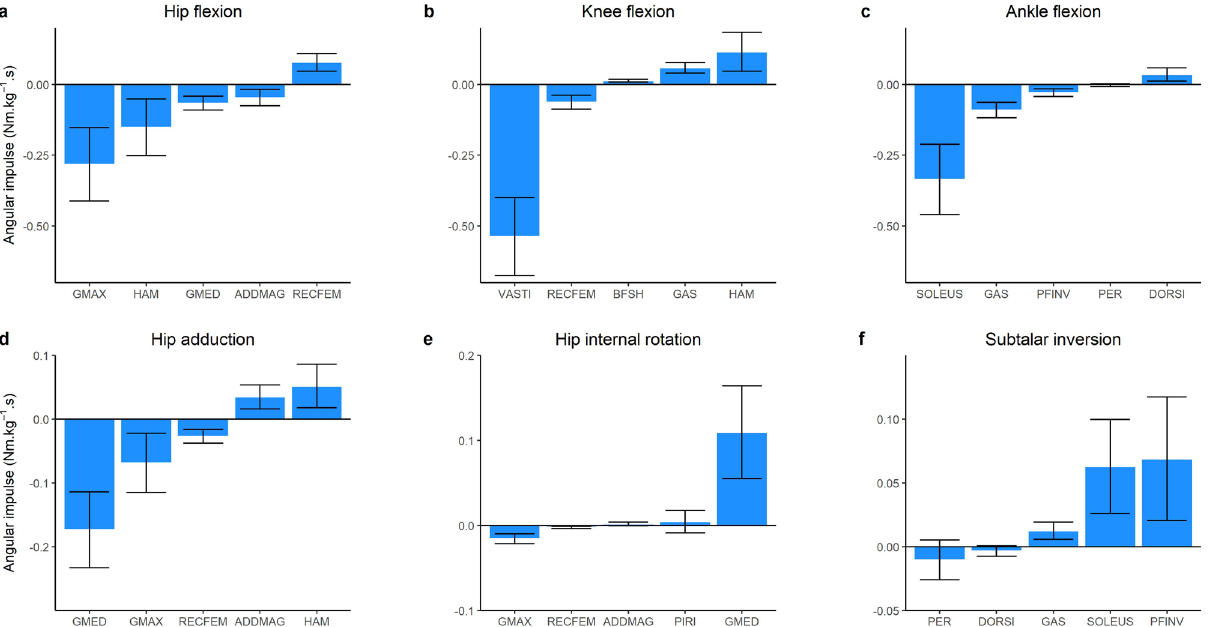
Figure 6. Mean (bars) and SD (error bars) musculotendinous contributions to the body mass normalised joint angular impulse across the landing phase (initial contact to peak knee flexion) of a single-leg drop landing from a 0.31 m height. Positive values are indicated by the y-axis title. GMAX, gluteus maximus; HAM, biarticular hamstrings (sum of biceps femoris long head, semimembranosus, and semitendinosus); GMED, gluteus medius (sum of gluteus medius and minimius), ADDMAG, adductor magnus; RECFEM, rectus femoris; VASTI, vasti (sum of vastus intermedius, lateralis and medialis); BFSH, biceps femoris short head; GAS, gastrocnemius (sum of lateral and medial gastrocnemius); SOLEUS, soleus; PFINV, plantar flexor invertors (sum of tibialis posterior, flexor hallucis and digitorum longus); PER, peroneus (sum of peroneus longus and brevis); DORSI, ankle dorsiflexors (sum of tibialis anterior, extensor hallucis and digitorum longus); PIRI, piriformis.